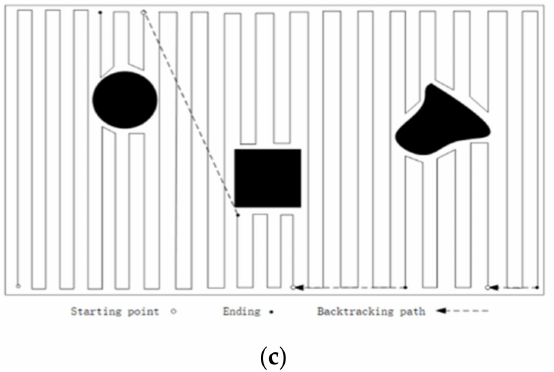
Figure 1. ( a ) Environment map; ( b ) connected graph of generated from ( a ); ( c ) CCPP based on backtracking